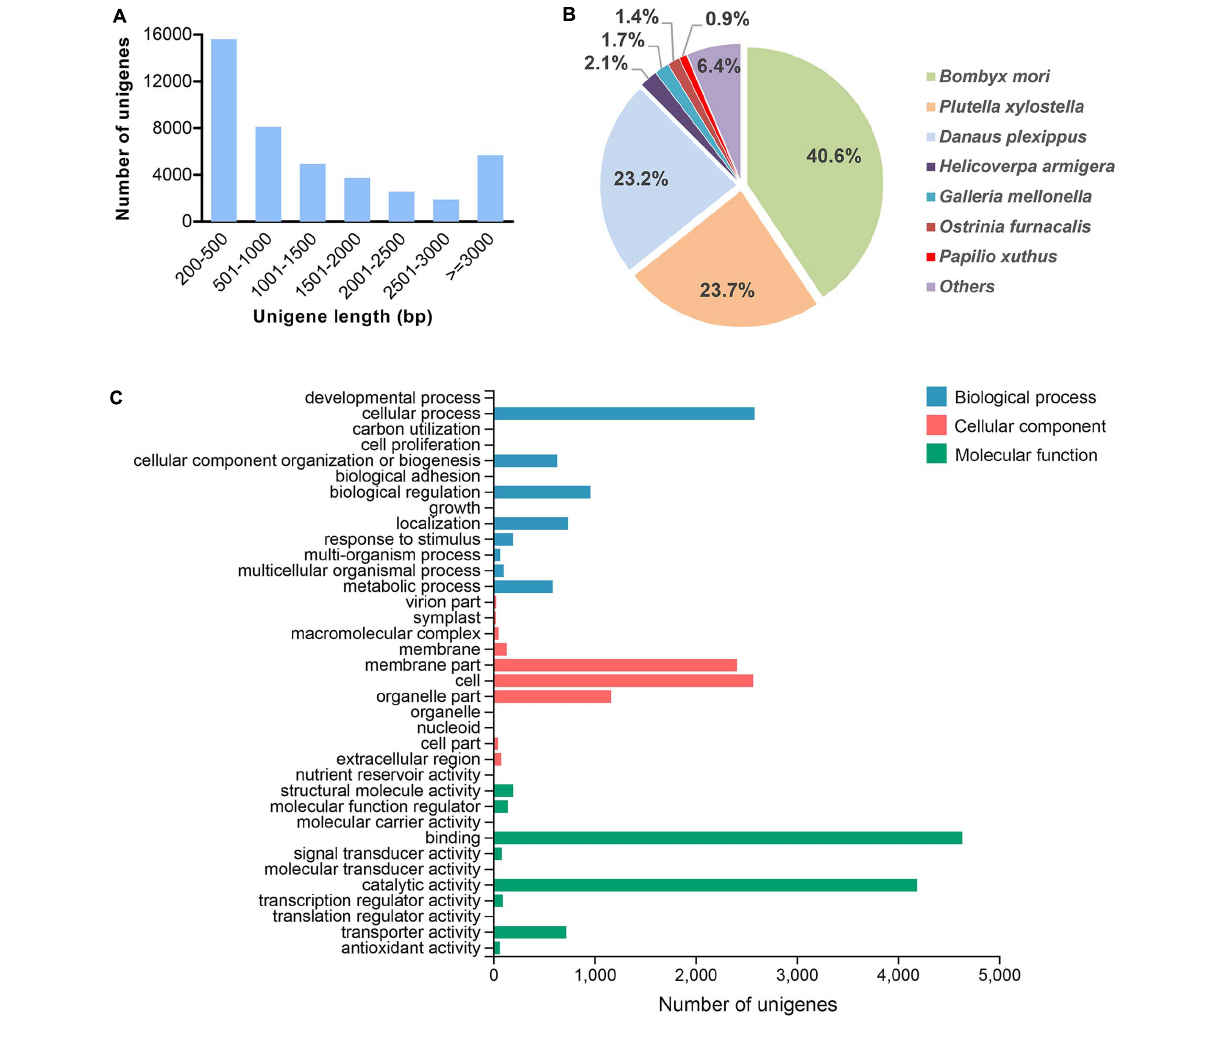
FIGURE 1 | Summary of the G. mellonella unigene assembly. (A) Size distribution of unigenes. (B) Species distribution of unigenes based on homology searching against the NCBI NR database. (C) GO classification of